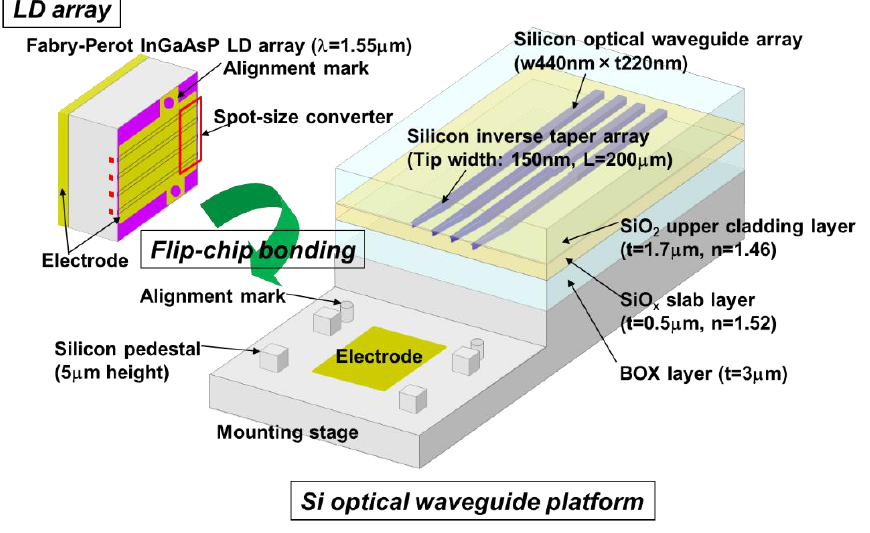
Figure 2. Schematic of hybrid integrated light source with LD array on silicon platform made using SSC with SiO x slab